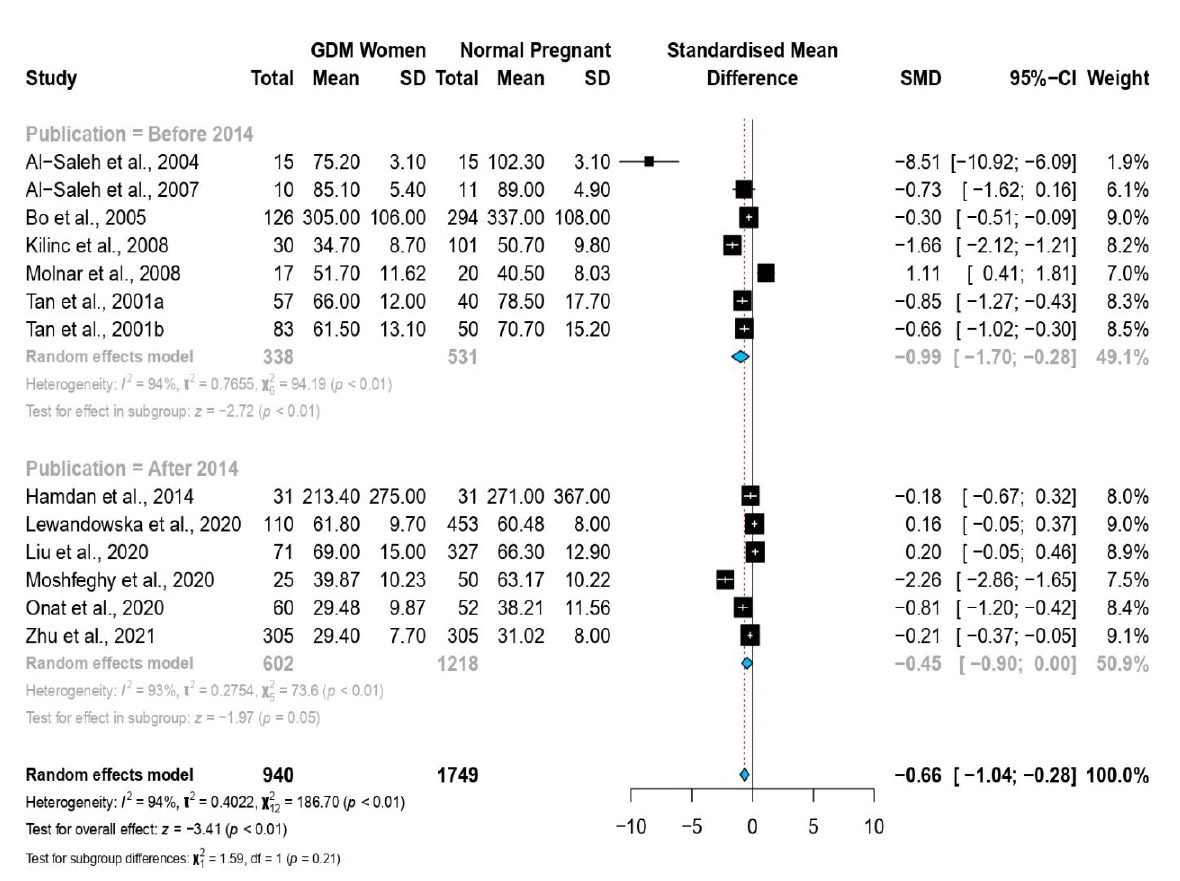
Figure 4. Forest plot of the association between selenium SMD levels and gestational diabetes mellitus; stratified meta-analysis according to year of publication [20–26,29,31,38,43,44]. Table 2. Meta-regression analysis of the factors possibly affecting selenium